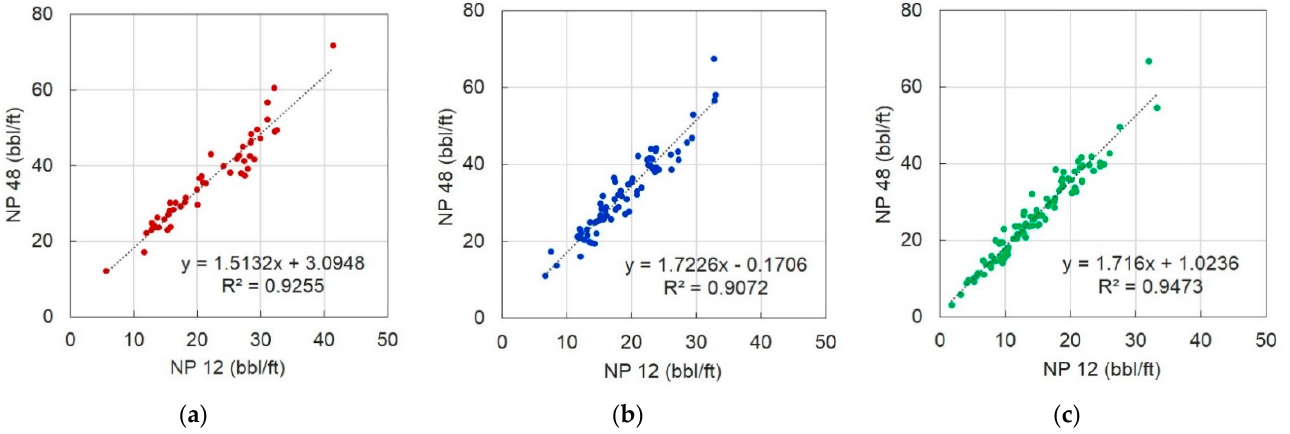
Figure 16. Relationship between NP 12 and NP 48 by group: ( a ) Cluster 1; ( b ) Cluster 2; ( c ) Cluster 3. Table 5. AAPE of the estimated production results by group.